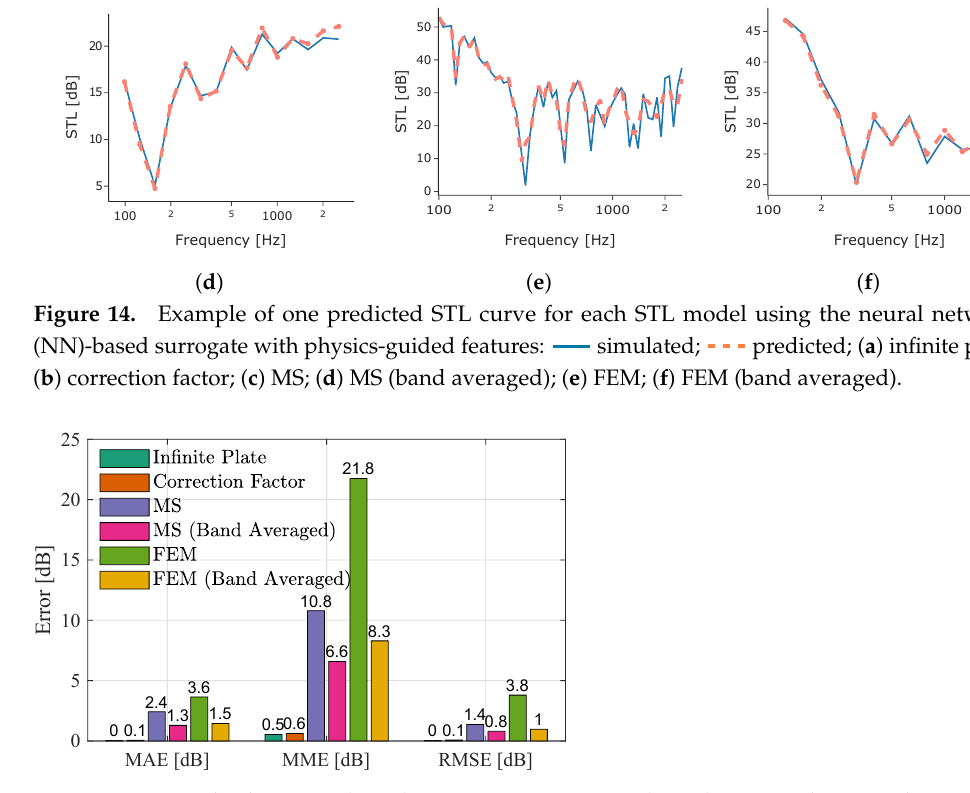
Figure 15. Mean absolute error (MAE), mean maximum error (MME) per STL design and root mean square error (RMSE) of the NN-based surrogate model with physics-guided